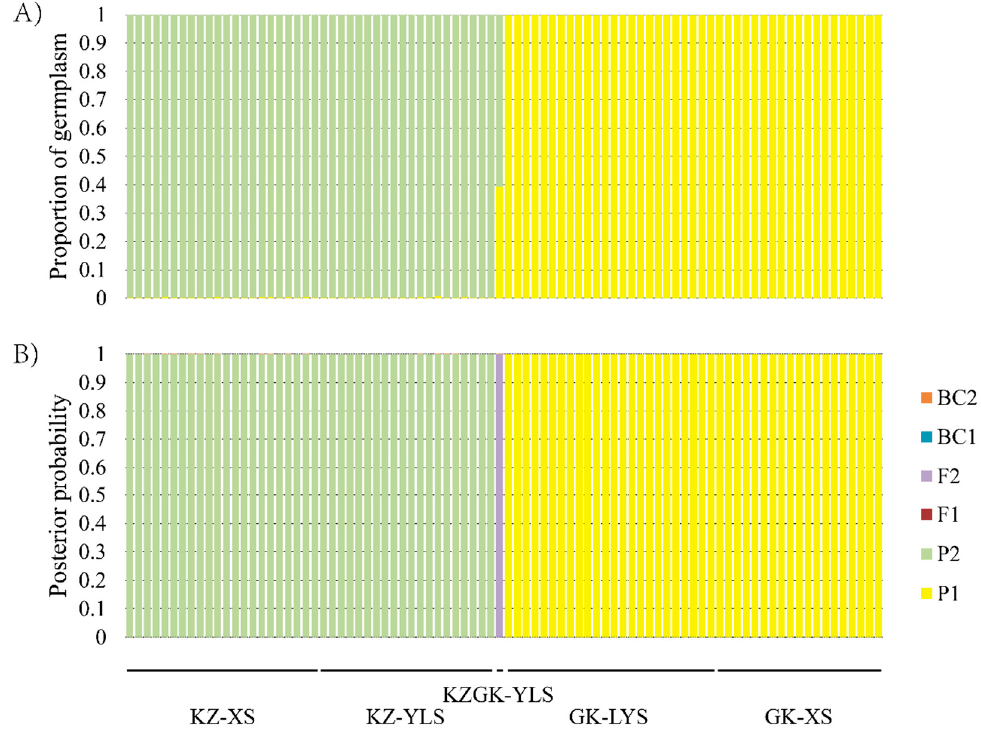
Figure 2. ( A ) Genetic admixture coefficient of the samples; ( B ) posterior probability of genotype category evaluated based on nuclear microsatellite markers. Population codes are the same as in Table 1.